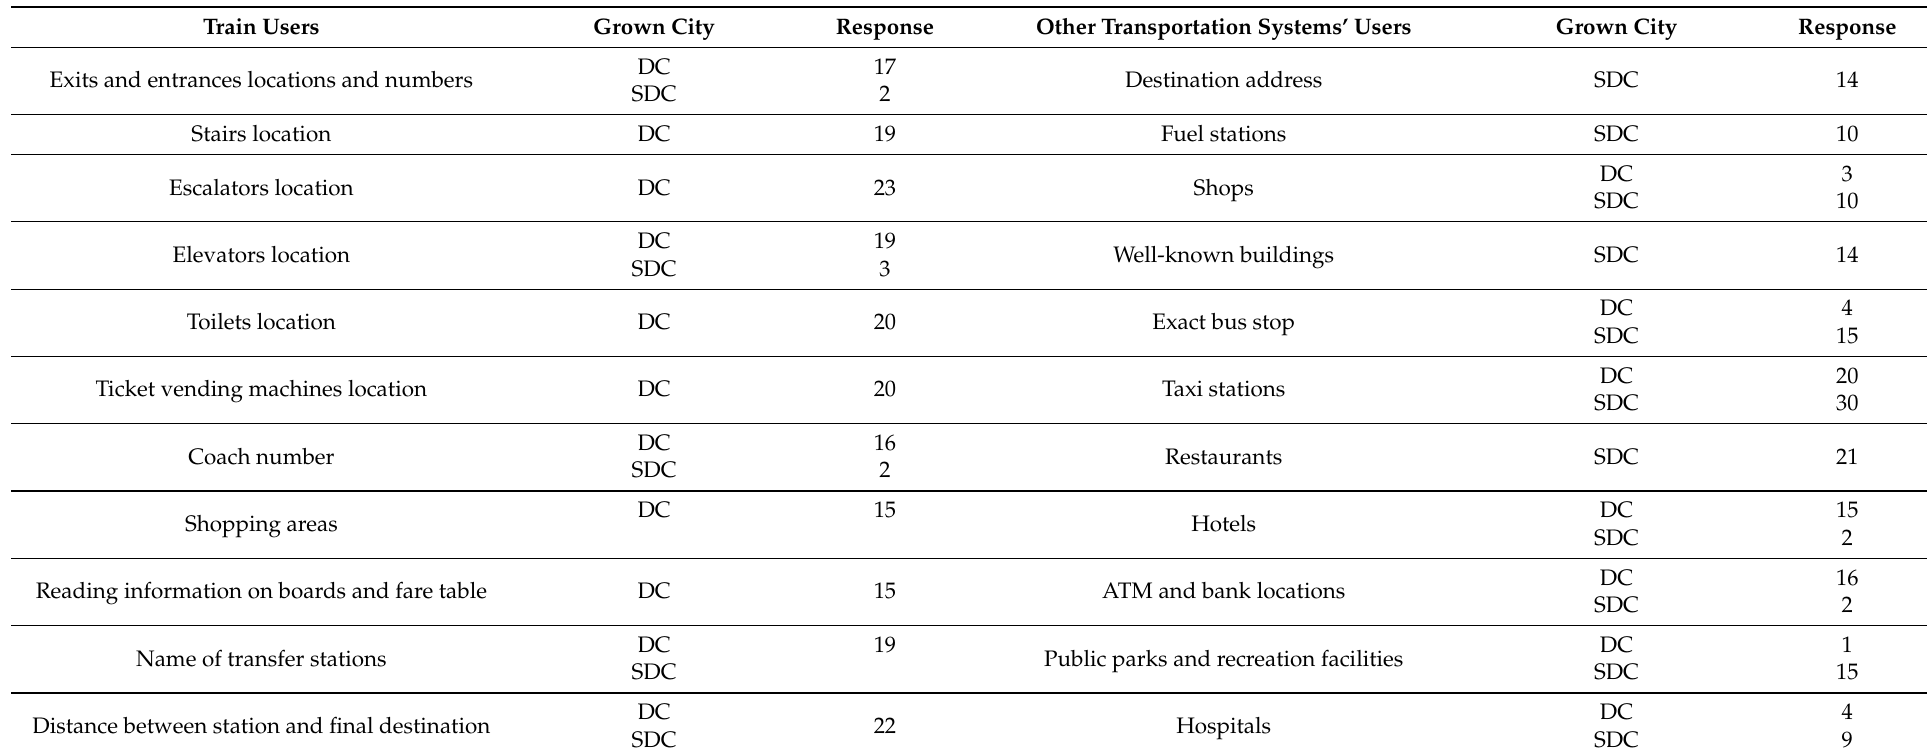
Table 2. Essential information required by the participants while navigating at an unfamiliar